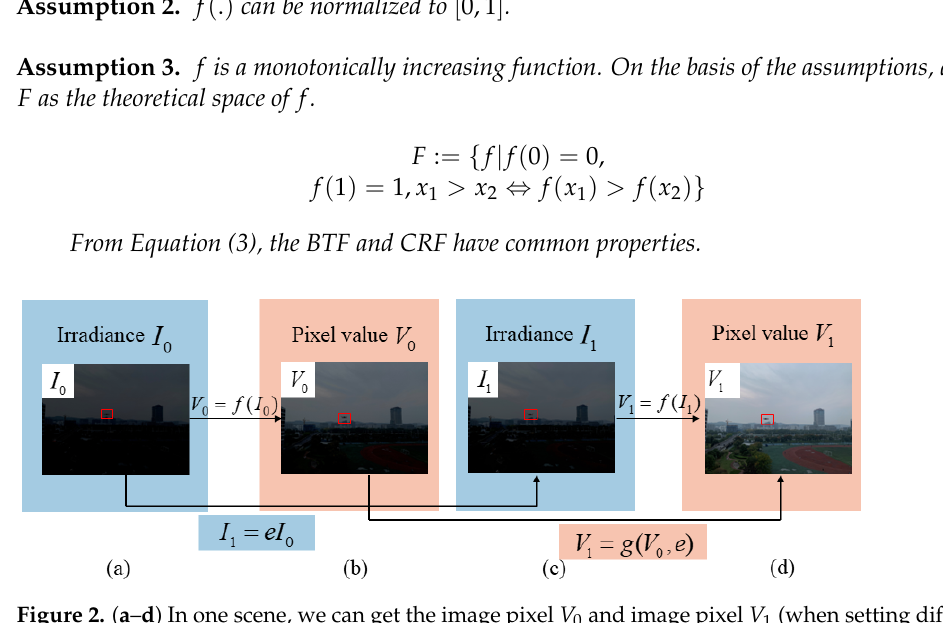
Figure 2. ( a – d ) In one scene, we can get the image pixel V 0 and image pixel V 1 (when setting different exposures) which correspond to irradiance I 0 and irradiance I 1 ,